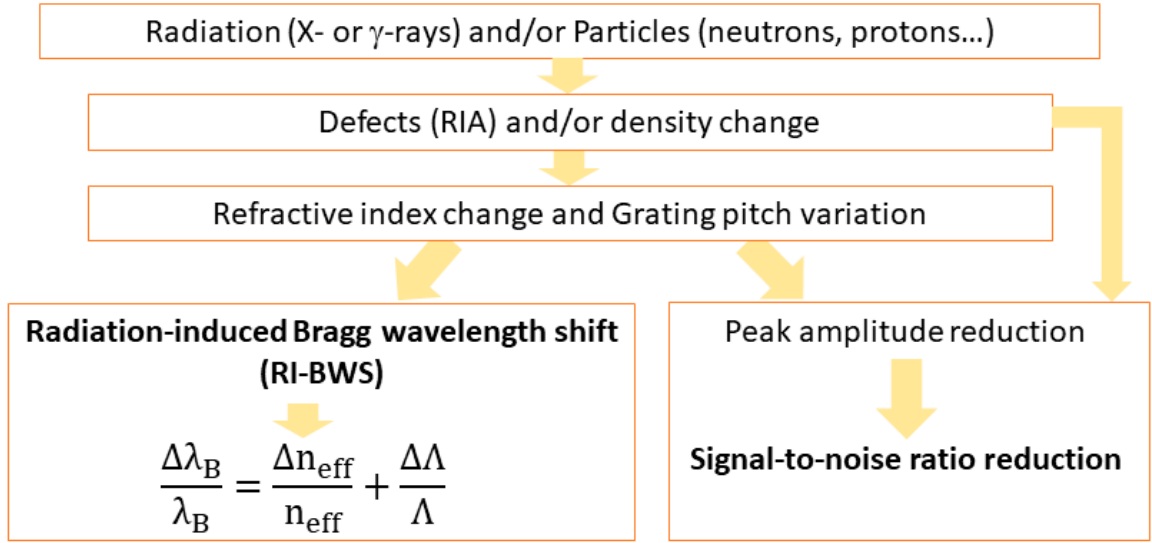
Figure 2. An example of the radiation-induced effects on a Bragg peak reflection spectrum, before (black line) and after (red line) X-ray irradiation at 1.5 MGy TID at RT. Data extracted from [73].